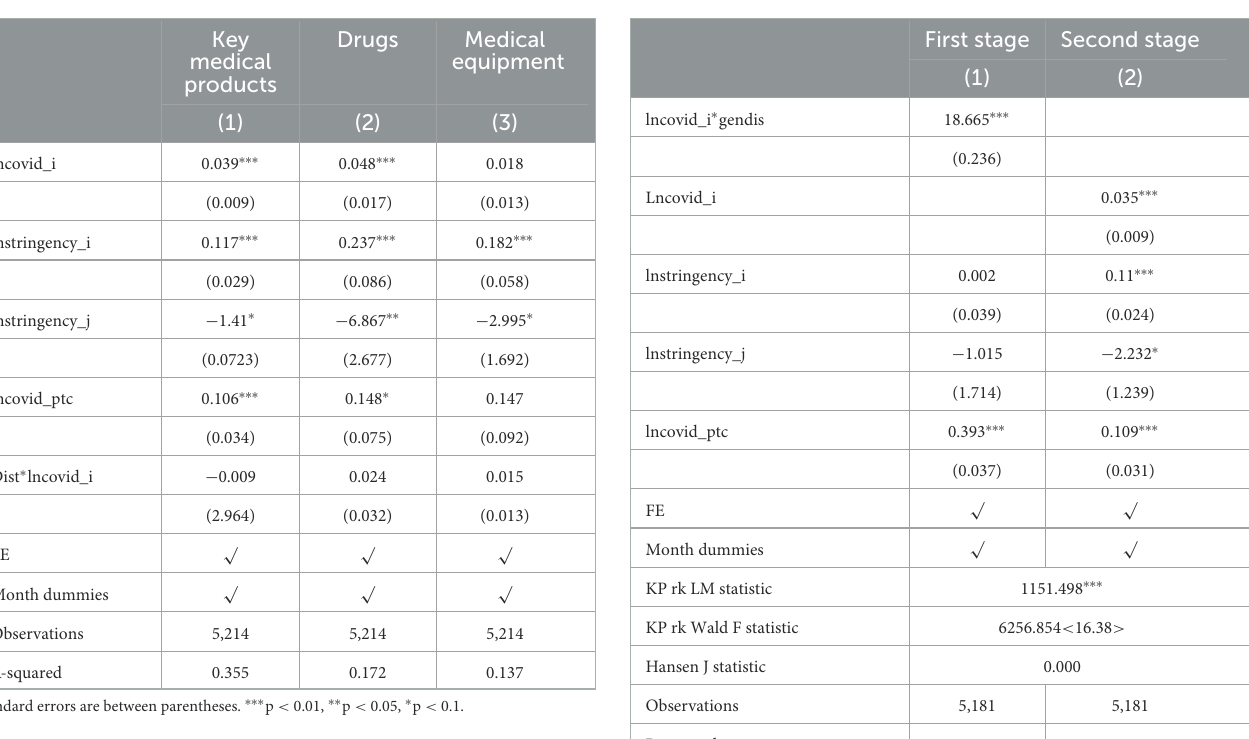
TABLE 7 Geographical